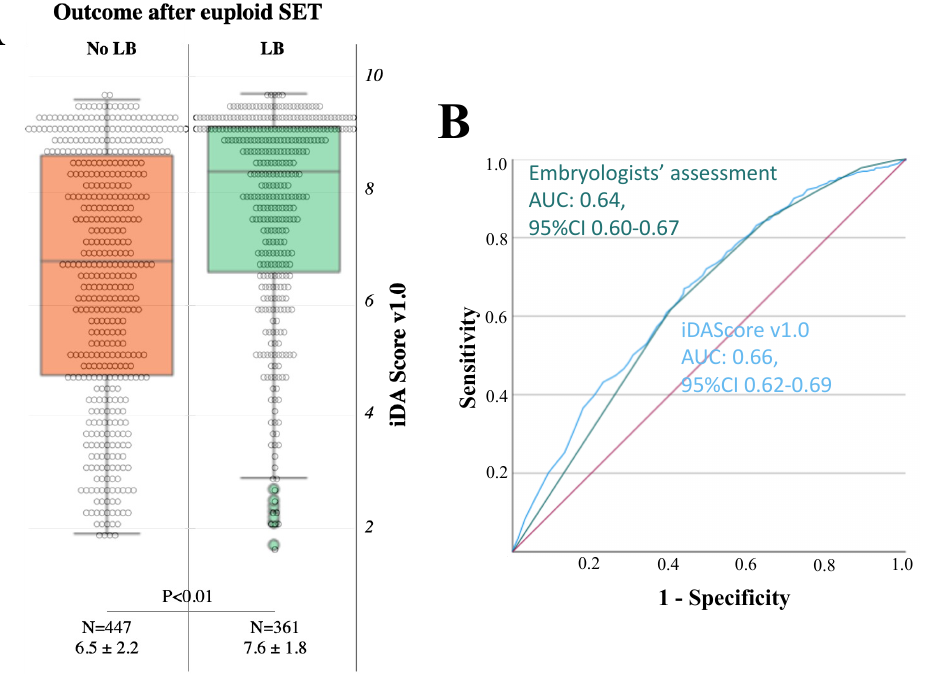
Figure 7. iDAScore v1.0 is associated with live birth (LB) after euploid blastocysts single embryo transfer (SET), but the AUC is 0.66. ( A ) Association between iDAScore v1.0 and a negative (no LB) or positive (LB) clinical outcome; ( B ) Receiver operating characteristic (ROC) curve analysis. The green curve represents the discrimination of embryologists’ assessment upon a LB after euploid blastocyst SETs with an area under the curve (AUC) of 0.64, while the blue curve represents the discrimination of iDAScore v1.0 upon a LB after euploid blastocyst SETs with an AUC of